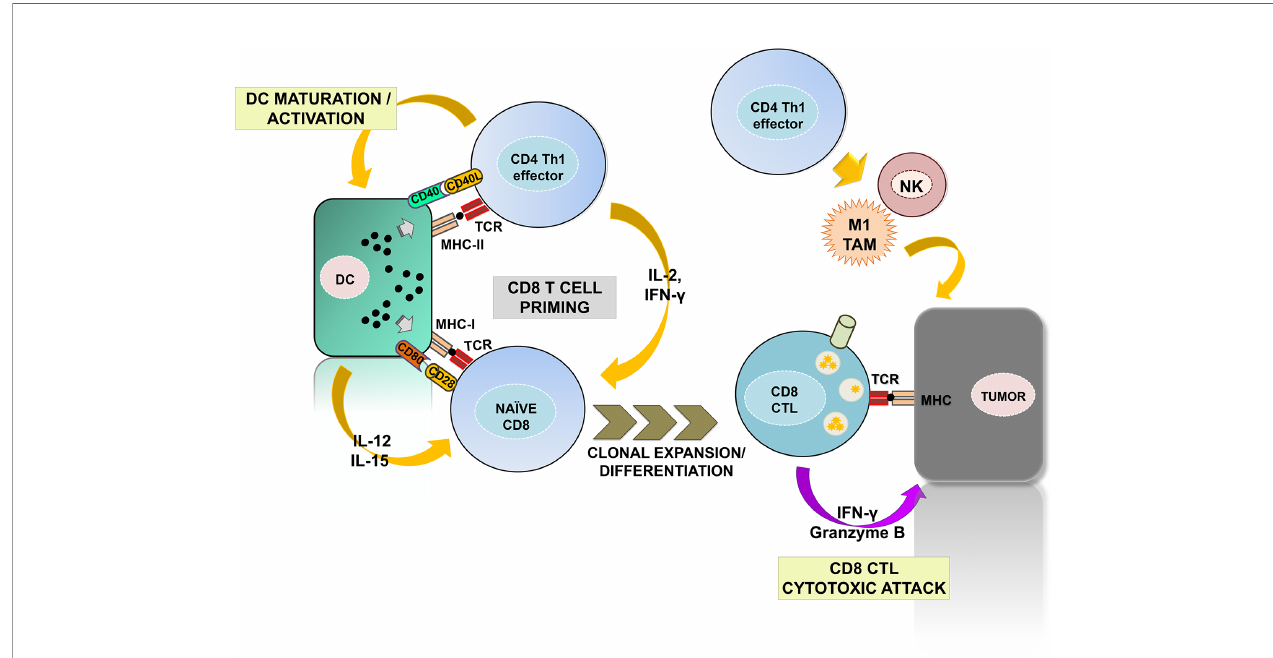
FIGURE 1 | The contribution of CD4 Th1 subsets to anti-tumor immunity. The fi gure summarizes the well-established roles of CD4 Th1 subsets in anti-tumor responses. Right, CD4 Th1 cells allow the correct priming and differentiation of naïve CD8 T into CTLs by secretion of cytokines and co-stimulatory interactions with DCs within the secondary lymphoid organs. This process termed “ DC licensing ” leads to DC maturation by CD40L-CD40 binding. CD40-CD40L signaling on DCs induces production of IL-12 and IL-15 and up-regulates co-stimulatory ligands CD80, CD86, and CD70, providing the required signals for CD8 CTL priming. CD80, CD86, and CD70 co- stimulatory ligands on activated DC bind to their receptors CD28 and CD27 on naïve CD8 T cells leading to CTL differentiation and survival. CD8 CTLs in fi ltrate tumors and exert cytotoxic responses against tumor cells after TAA recognition. Within the tumors, Th1 cells activate NK and M1-macrophages enhancing their innate anti-tumor responses. Th1, T helper 1; CTL, cytotoxic T lymphocyte; DC, dendritic cell; NK, natural killer; M1 TAM, type-1 tumor associated